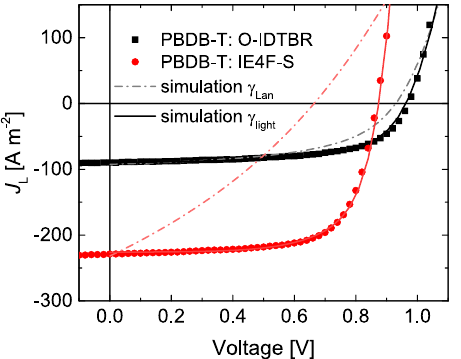
Figure 2. Current density–voltage characteristics of solar cells comprising a PBDB-T:O-IDTBR or PBDB- T:IE4F-S active layer. The symbols represent experimental characteristics, the solid lines are fits of the data by drift diffusion simulations, with the experimental charge-carrier mobilities as input. With the mobilities known, the recombination rate determines the fill factor, where the results for Langevin recombination ( γ = 1) are represented by the dash-dotted lines.